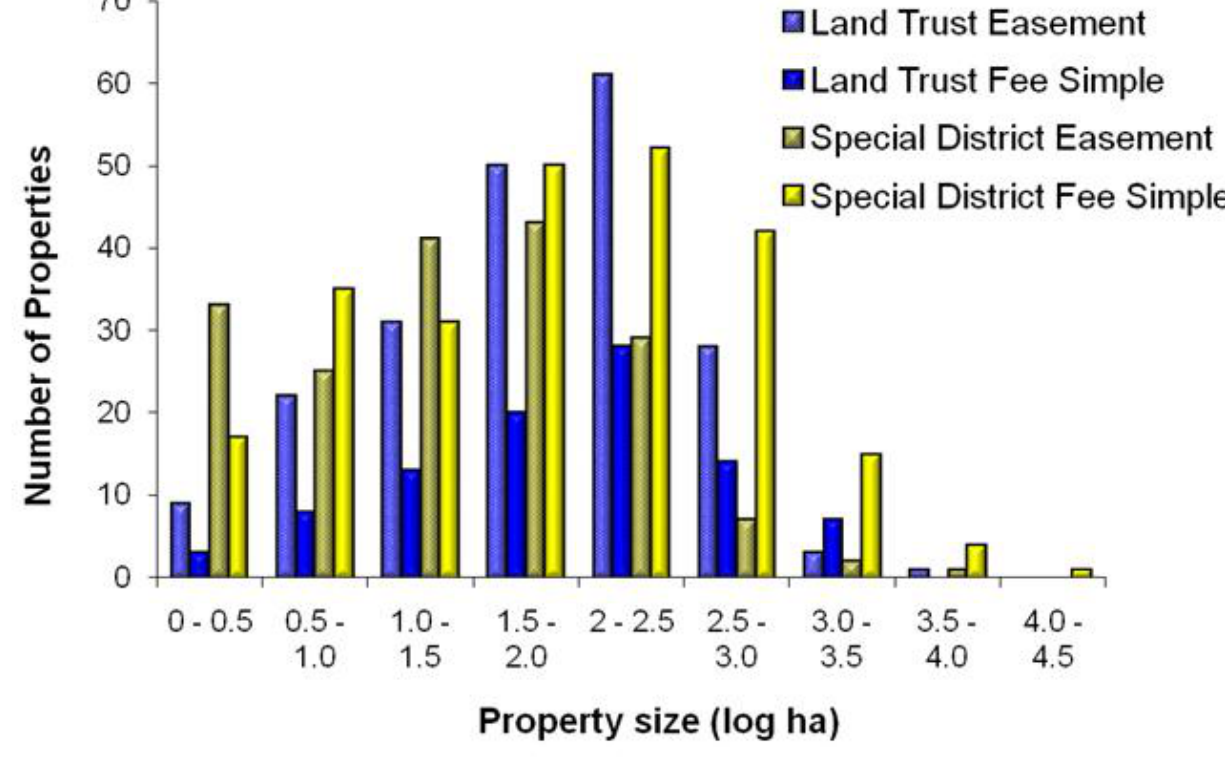
Fig. 4 . Size distribution of properties held by land trusts and special districts, the two primary landowners that held conservation easements as well as fee-simple